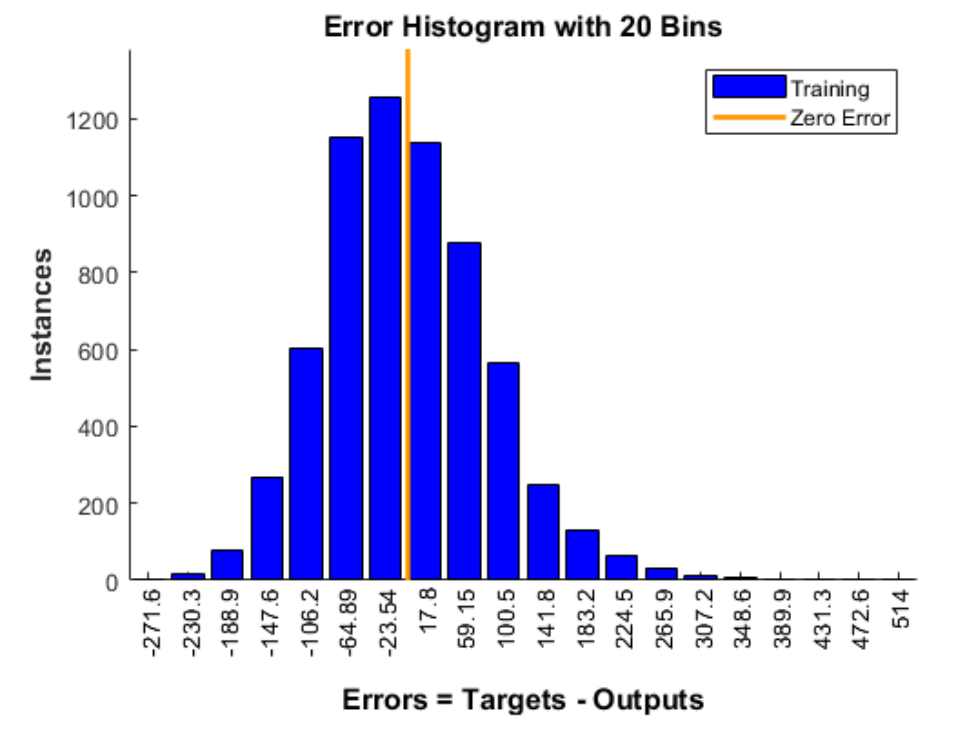
Figure 12. Error histogram distribution curve of the RP-LIDAR range data.